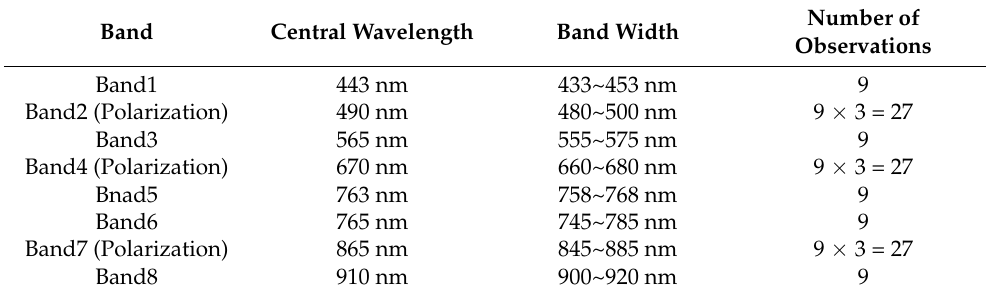
Number of Observations